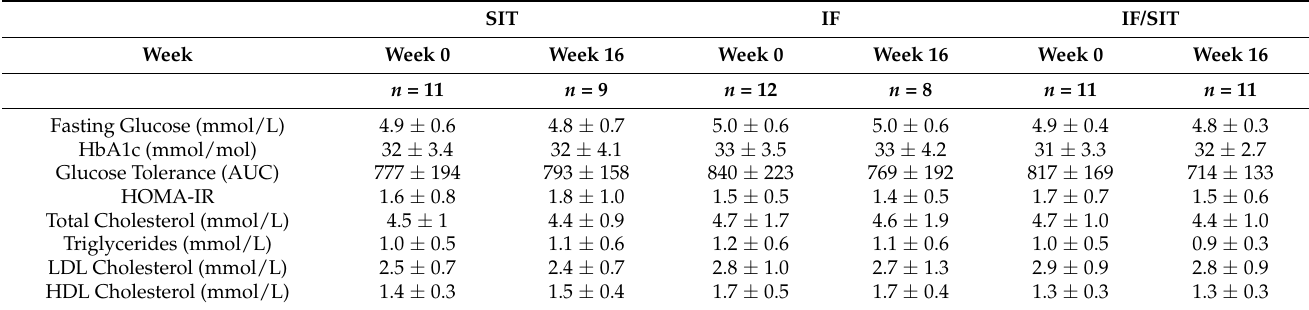
Table 4. The effect of diet and/or exercise intervention on cardiometabolic biomarkers.